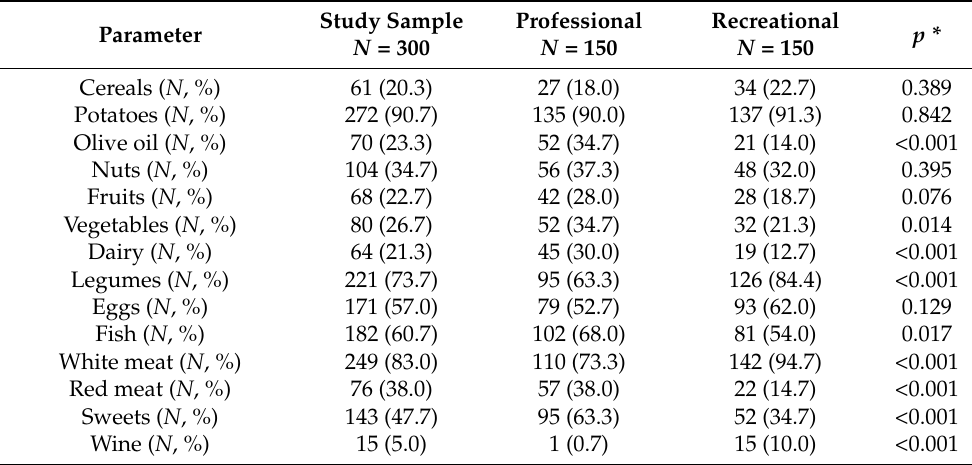
Table 2. Adherence to MDSS components and differences between groups.